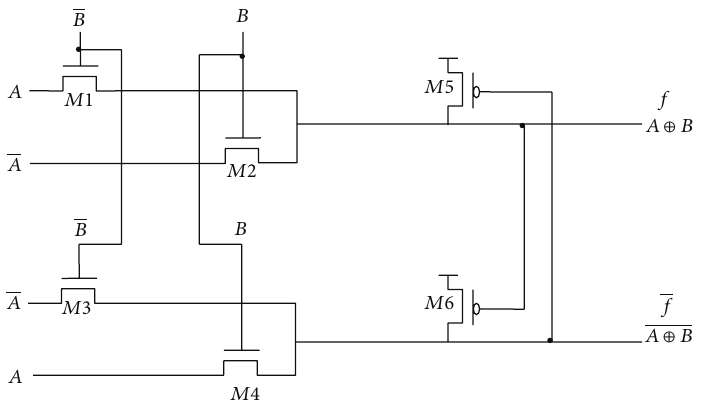
Figure 5: CPL with level restorer.